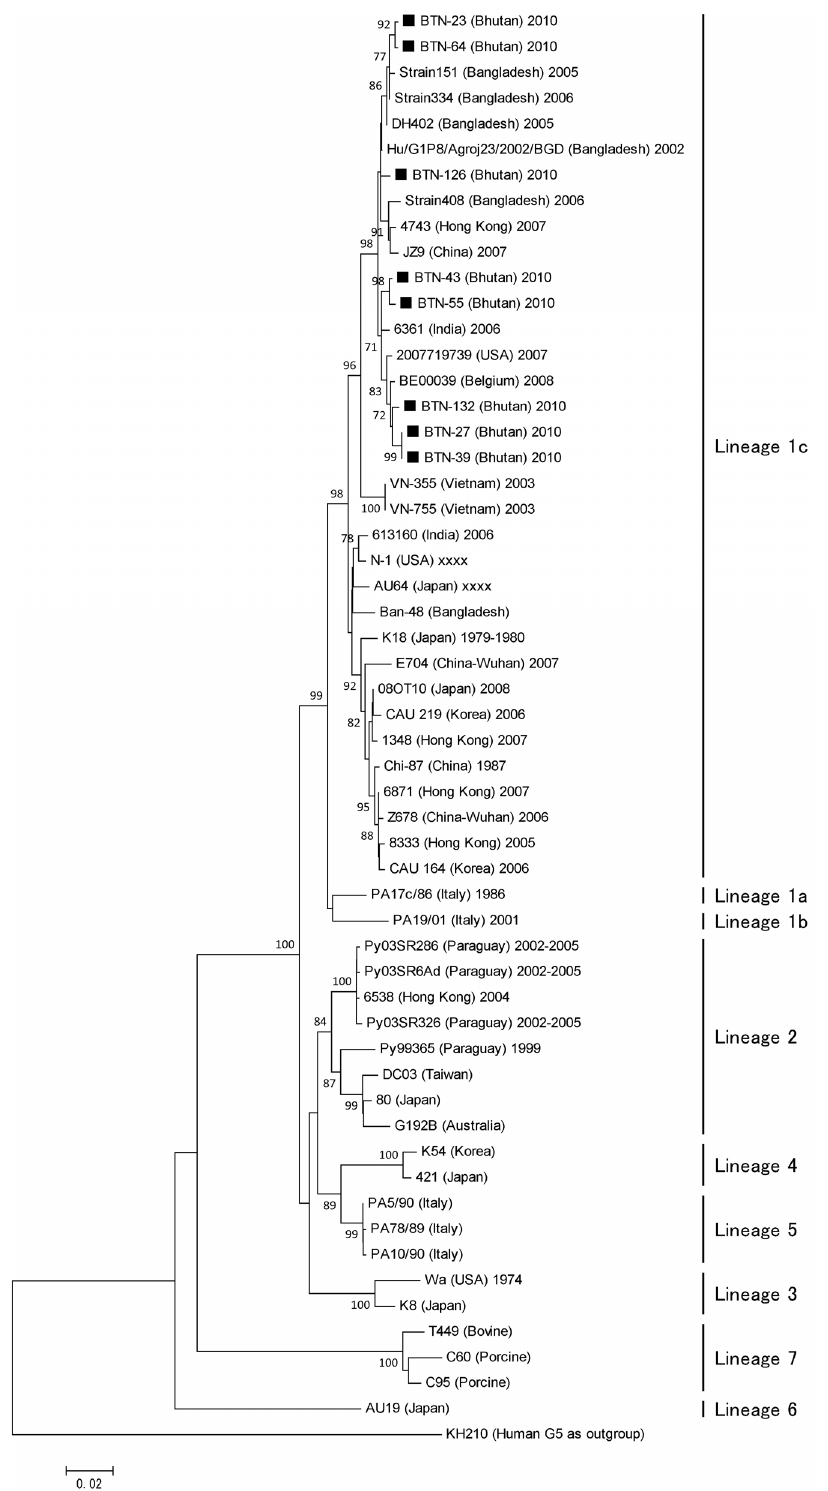
Figure 2. Phylogenetic tree constructed based on the deduced amino acid sequences of the VP7 genes of G1 strains. Bhutanese strains are indicated by black squares, which are followed by the strain numbers. Human rotavirus KH210 (G5) was used as an outgroup. The numbers adjacent to nodes represent the bootstrap values; values , 70% have not shown. The scale bar shows the genetic distance, which is expressed as amino acid substitutions per site. The DNA Data Bank of Japan/European Molecular Biology Laboratory/GenBank accessions numbers are: AB905455 (rotavirus strain BTN-23), AB905456 (BTN-64), AB905457 (BTN-55), AB905458 (BTN-126), AB905459 (BTN-43), AB905460 (BTN-132), AB905461 (BTN-27), and AB905462 (BTN-39).